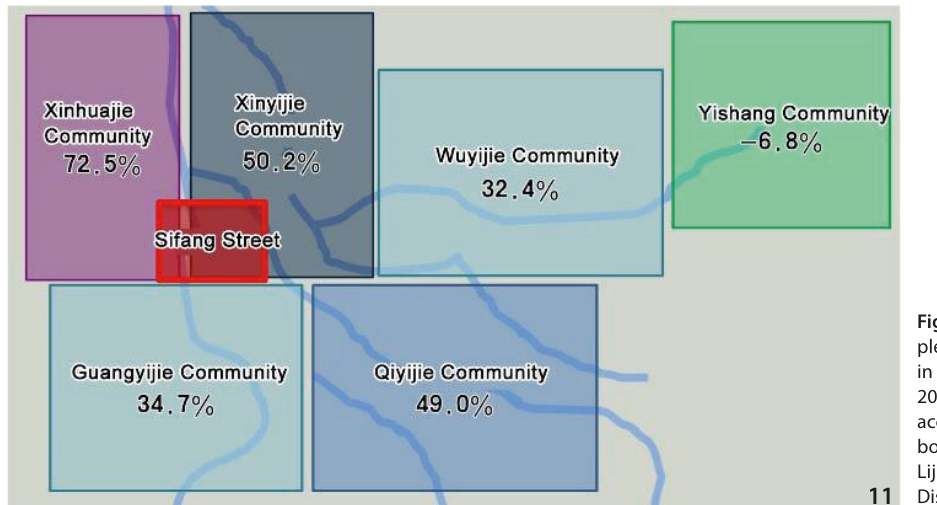
Figure 11 Ratio of indigenous peo- ple moving out of each community in Dayan Old Town, between 2005– 2011 (Source: Drawn by the author according to the statistical year- books and statistical bulletins of Lijiang Municipality and Gucheng District, and the social